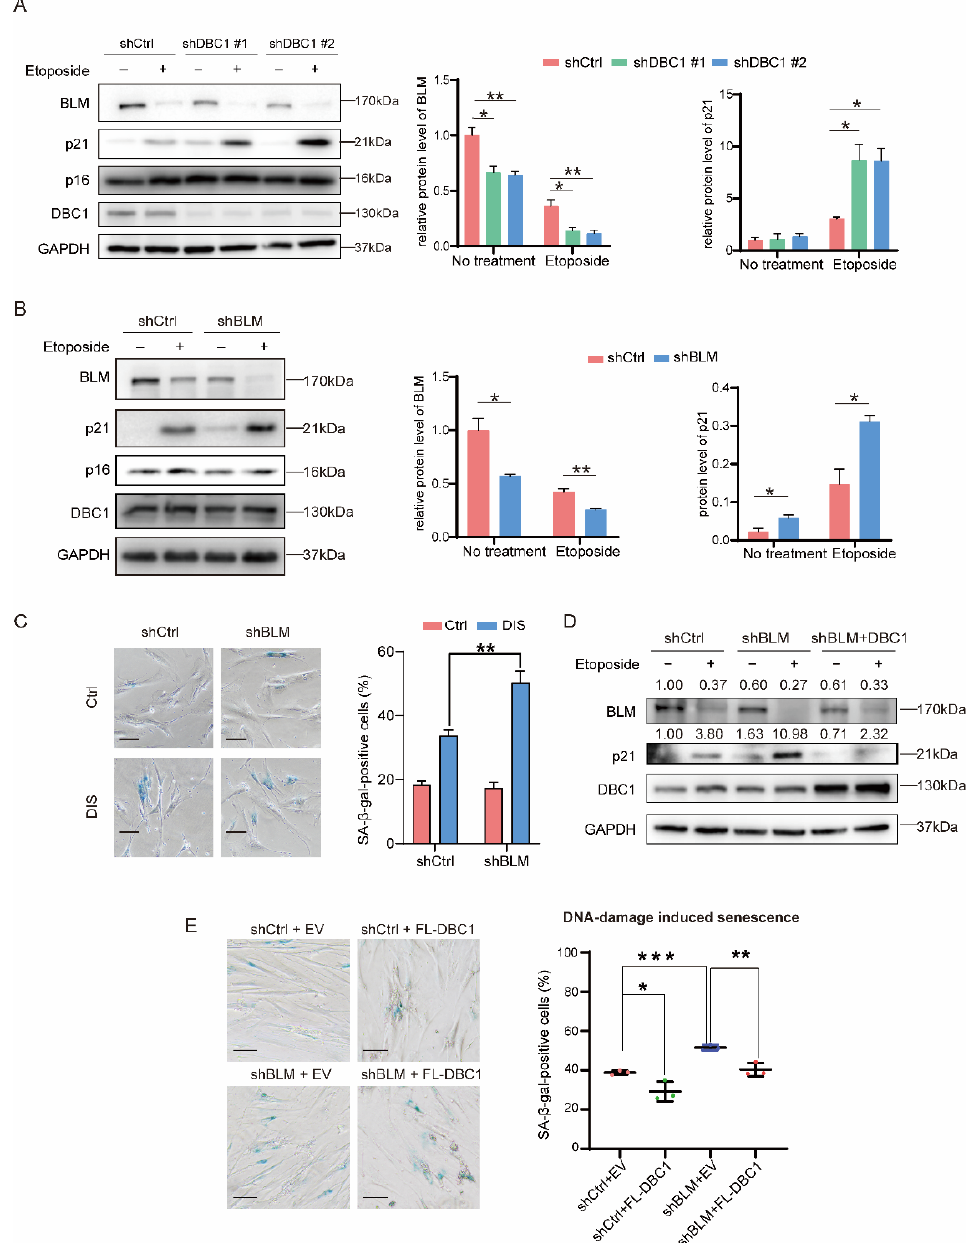
Figure 2. DBC1 regulates DNA damage-induced senescence by maintaining BLM abundance. ( A ) Western blotting analysis and quantification for BLM, p16 and p21 protein levels in DBC1 knockdown cells treated with etoposide (50 μM, 24 h). ( B ) Western blotting analysis and quantification for DBC1, BLM, p16 and p21 protein levels in BLM knockdown cells treated with etoposide (50 μM, 24 h). ( C ) SA-β-gal staining of BLM knockdown IMR-90 cells after DNA damage-induced senes- cence using etoposide or DMSO (see method 2.8 for the experiment procedure). The quantifications are shown in the right panel, n = 4 biological replicates. Scale bar = 100 μm. ( D ) Western blotting analysis for BLM and p21 protein levels in BLM knockdown 293T cells transfected with DBC1 after etoposide-induced DNA damage (50 μM, 24 h). ( E ) Representative images and quantification ( n = 3 biological replicates) of SA-β-gal staining of BLM knockdown IMR-90 cells transfected with DBC1 after DNA damage-induced senescence using etoposide or DMSO (Control) (see method for the experiment procedure). Scale bar = 100 μm. Data are presented as mean ± SD [E] or SEM [C]. During DNA damage p21 is induced to arrest the cell cycle, allowing DNA repair to take place [36]. In comparison with control cells, BLM knockdown cells displayed higher p21 induction (Figure 2B) but unchanged p53 and p16 expression levels (Figure 2B and